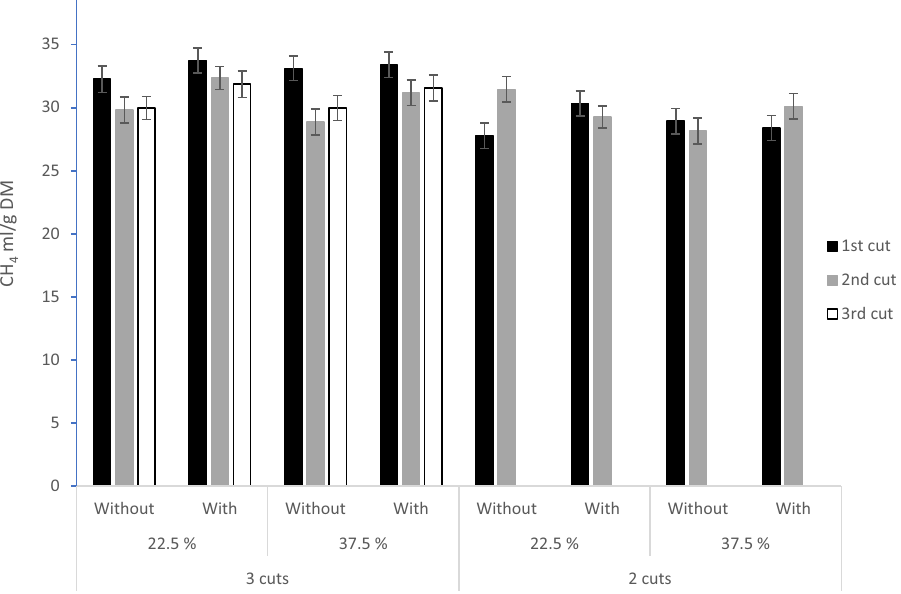
Figure 1. Three-way interaction between harvest regime (2 or 3 cuts per season), wilting levels (22.5% or 37.5% DM) and additive use (with or without formic acid-based additive) on in vitro methane production (mL/g DM). Bars represent standard error of the mean (n =